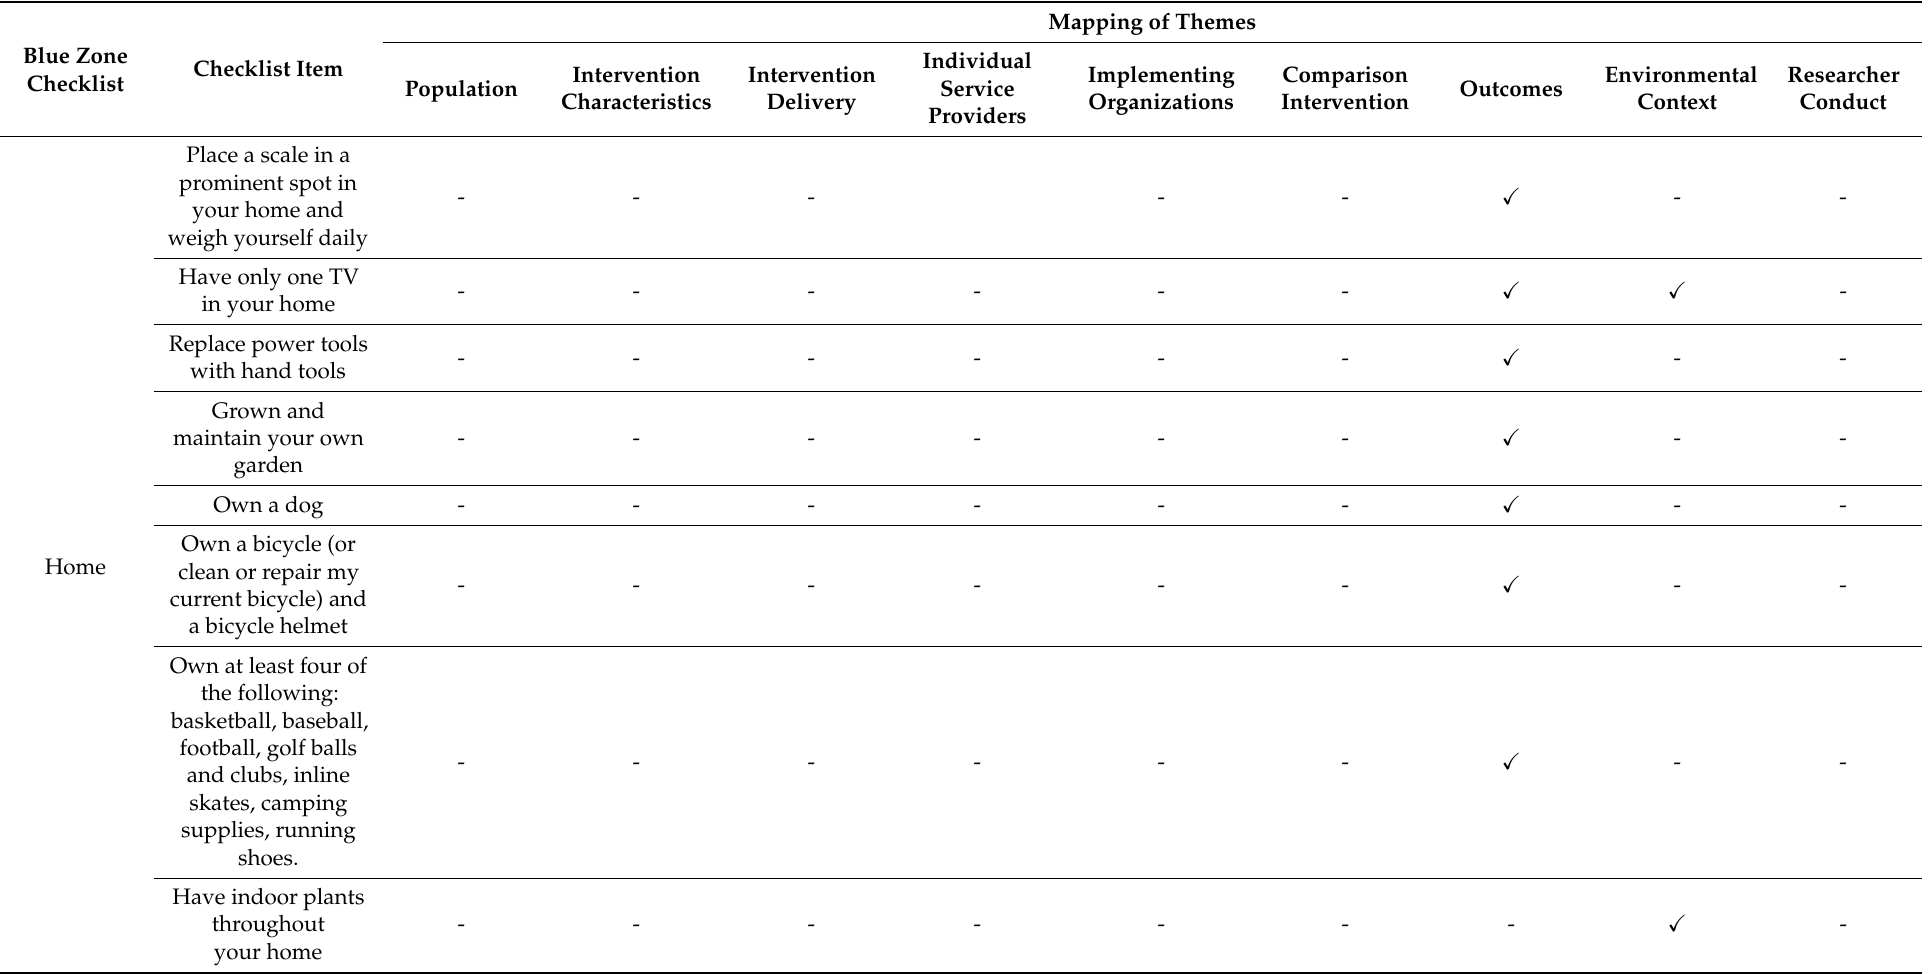
Table 8. Critical review of the “Home” checklist based on the systematic mapping by Munthe-Kaas et al. [60].